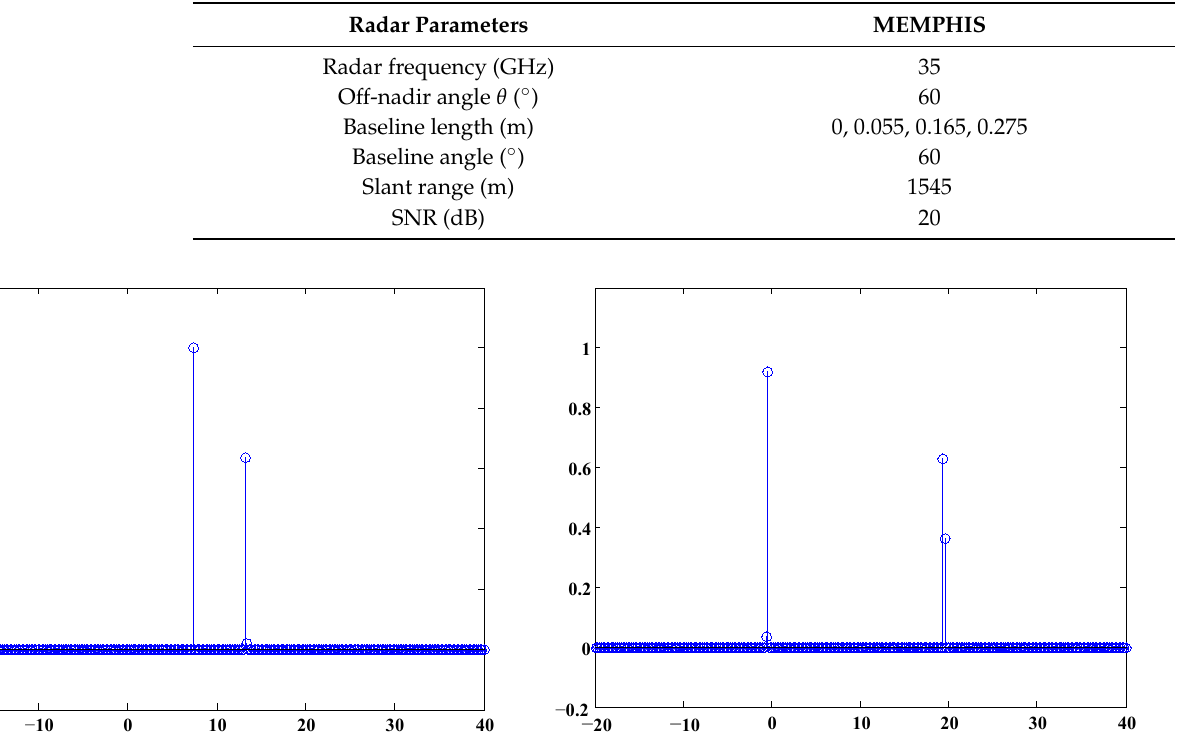
Table 1. System parameters of simulation data.